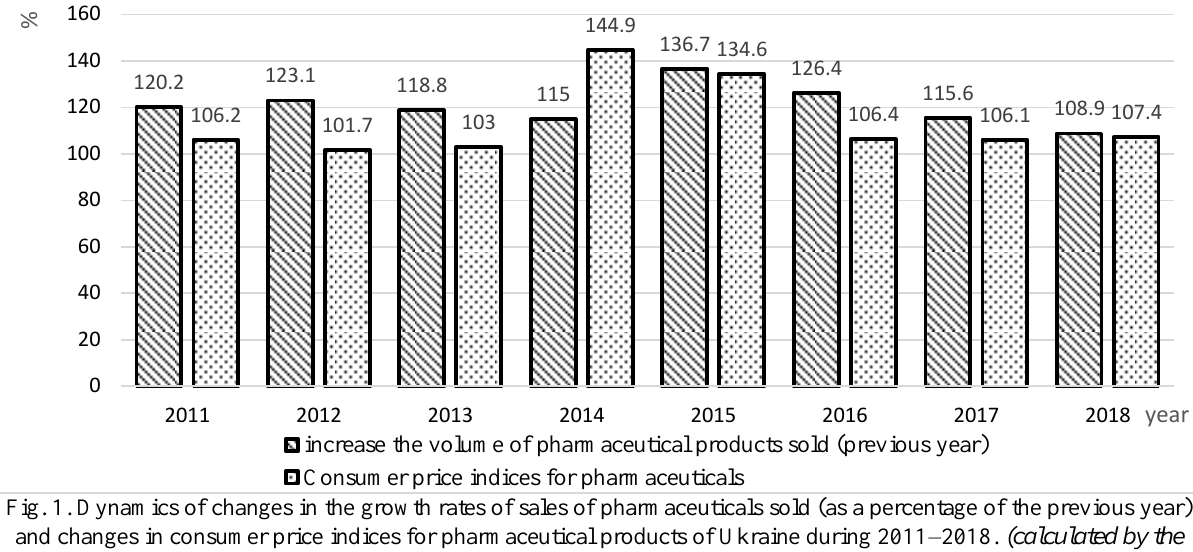
Fig. 1. Dynamics of changes in the growth rates of sales of pharmaceuticals sold (as a percentage of the previous year) and changes in consumer price indices for pharmaceutical products of Ukraine during 2011–2018. (calculated by the